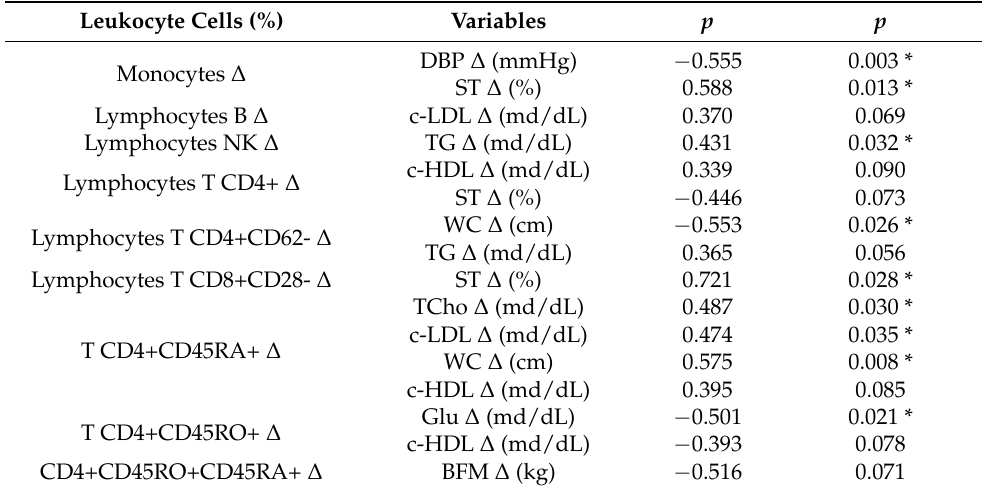
Table 4. Partial correlations and linear regressions after intervention between leucocytes and bio- chemical indicators, anthropometric measurements and body